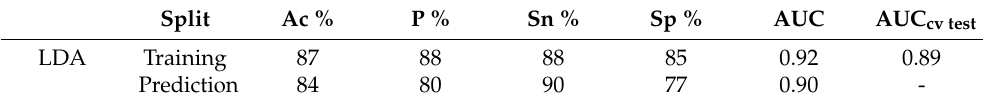
Table 2. Quality indicators calculated for the training set and for the prediction set.